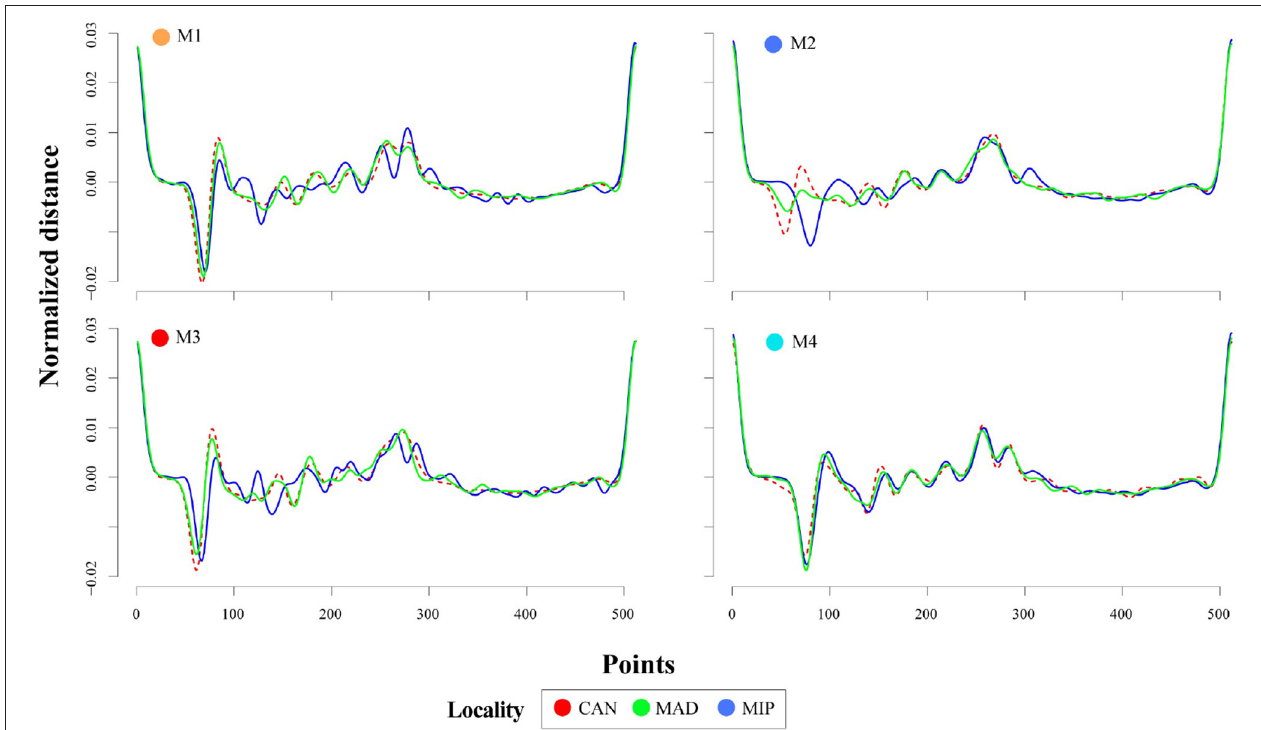
FIGURE 3 | Average decomposition of otolith contour using the 4th wavelet for the four phenotypes found in Trachurus picturatus off the north and central eastern Atlantic Ocean. CAN, Canary Islands; MAD, Madeira; MIP, mainland Portugal.